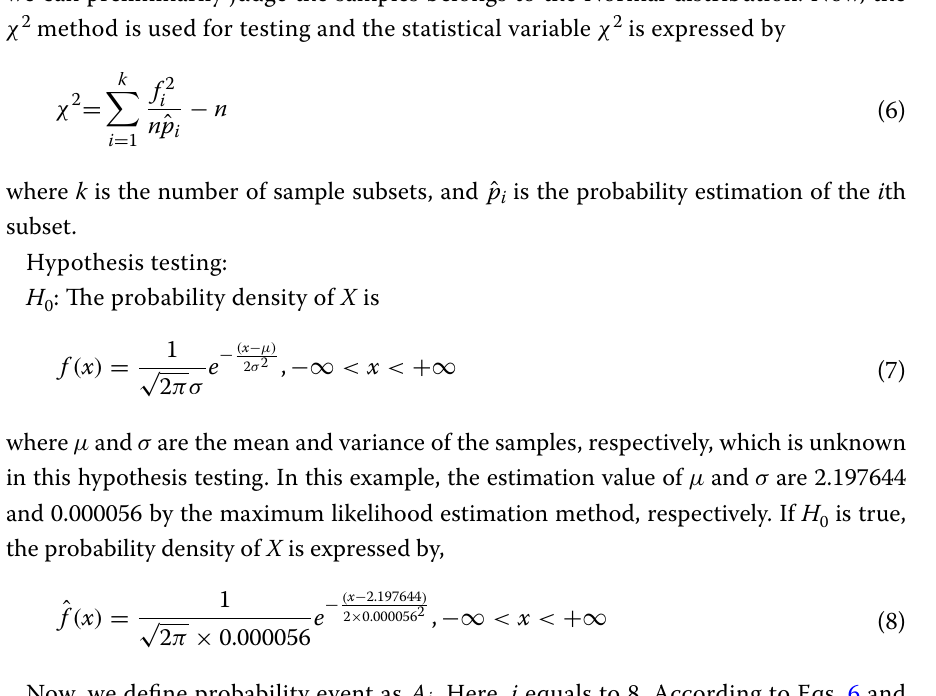
According to the data in Table 2, a small rectangle with small subset. Where f i is the counts of samples in the i th subset, n is the sample size